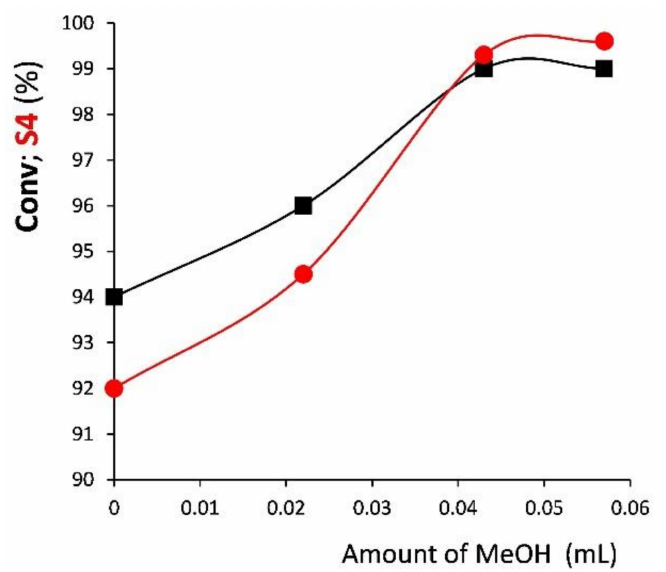
Figure 1. Effect of MeOH amount ( (cid:4) : Conv , conversion; • : S4 , selectivity of 4 —both determined by GC-FID). Reaction condition: 100 mg Amberlyst ® 15, 1 mmol 1 , 1.5–1.1 mmol 2 , total liquid volume of 0.213 mL, 35 pcs Ø 5 mm ZrO 2 balls, 30 Hz, 180